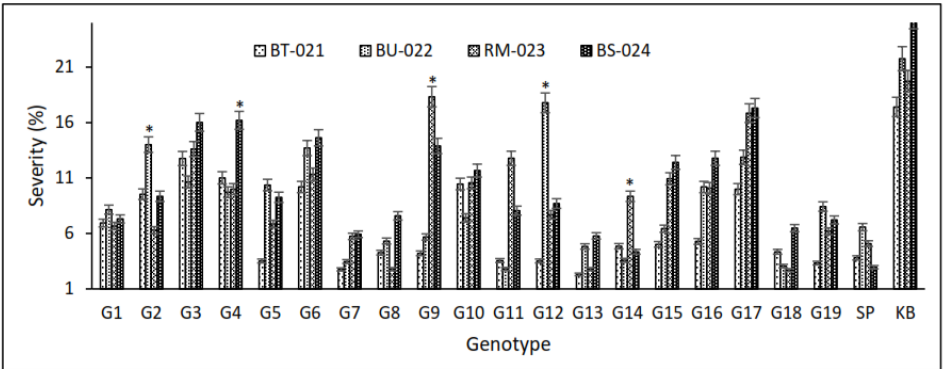
Figure 3. Expression of severity in 19 inbred upland rice lines, SP and KB as resistant and susceptible control varieties, respectively, which were inoculated with four isolates, BT-021 and BU-022, RM-023, and BS-024. Asterisks indicate statistical significance by two-tailed Student’s t -tests ( p < 0.05).